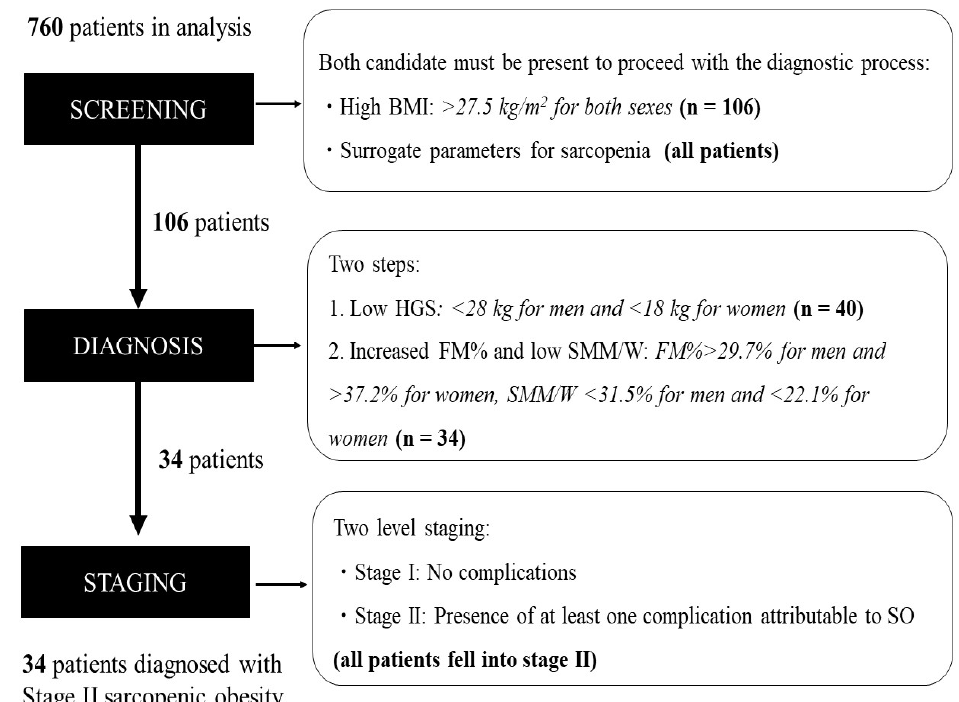
Figure 2. Screening, diagnosis, and staging of sarcopenic obesity according to the ESPEN and EASO- proposed diagnostic criteria. BMI, body mass index; FM, fat mass; HGS, handgrip strength; SMM/W, skeletal muscle mass divided by body weight; SO, sarcopenic obesity. As a reference, sarcopenic obesity was found in 60 of 760 patients (7.9% in total: 6.3% in women and 9.3% in men) when a BMI > 25.0 kg/m 2 was used for obesity screening